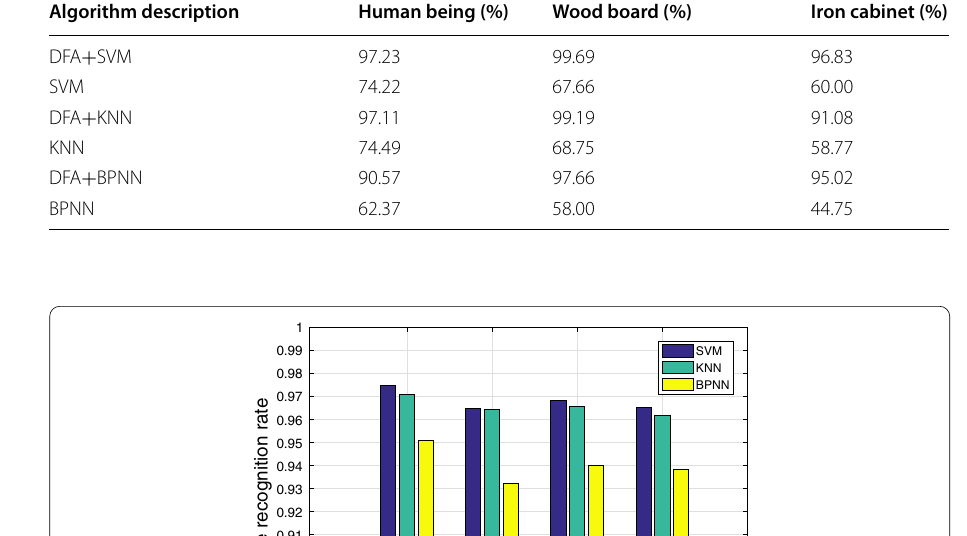
Table 6 Summary of classification accuracy (%) using different classifiers Algorithm description